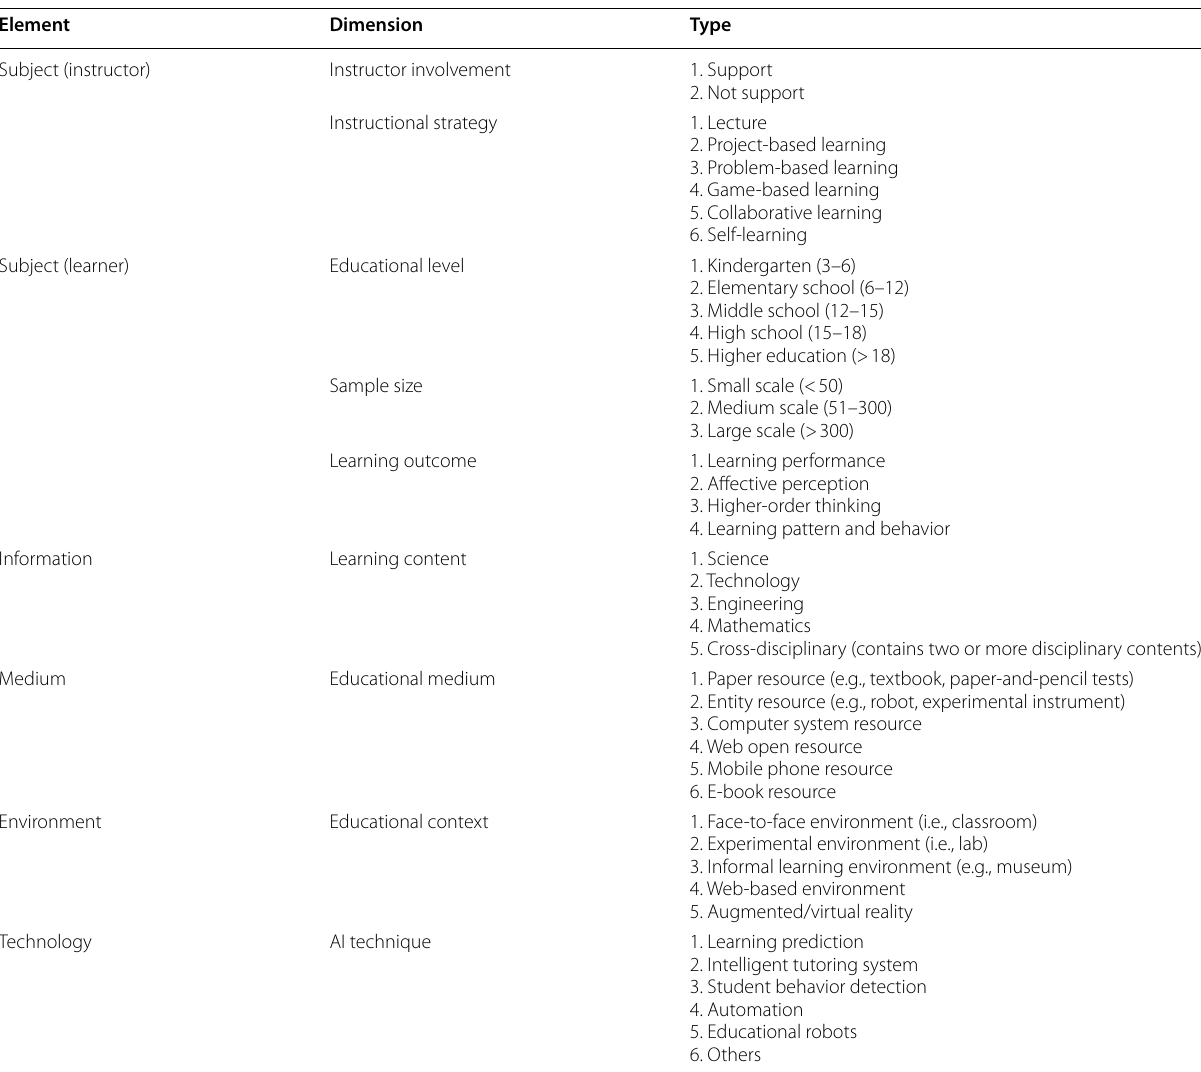
Table 2 The coding scheme Element